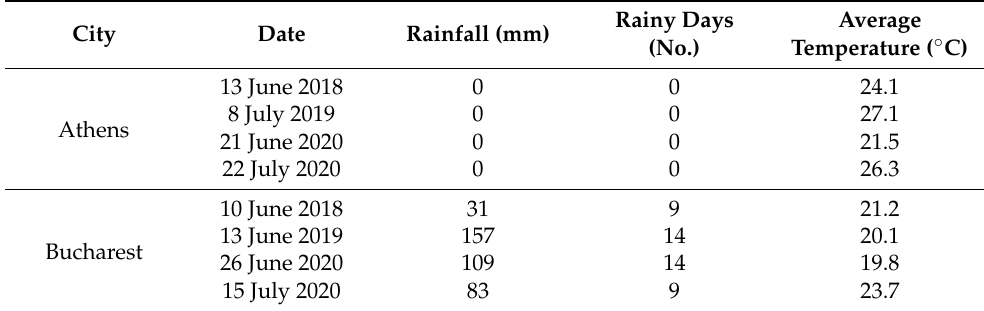
Table 5. Climatic conditions in Athens and Bucharest within the 30-day period before the analyzed images (Data from